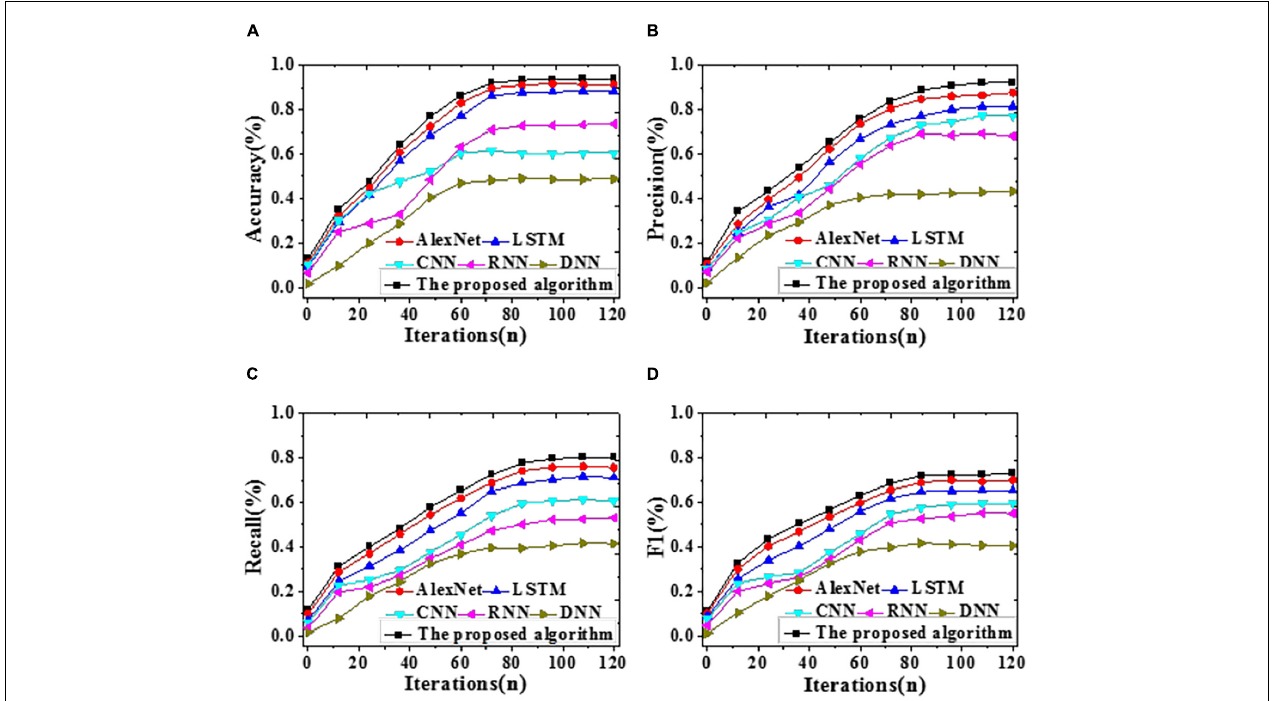
FIGURE 6 | The recognition accuracy of different algorithms with iteration on the training dataset [ (A) Accuracy; (B) Precision; (C) Recall; (D) F1 score].